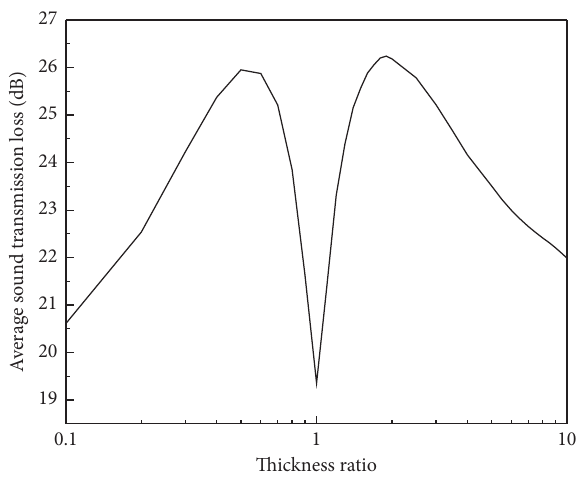
Figure 7: The average sound insulation of a simply supported double-panel partition under different thickness